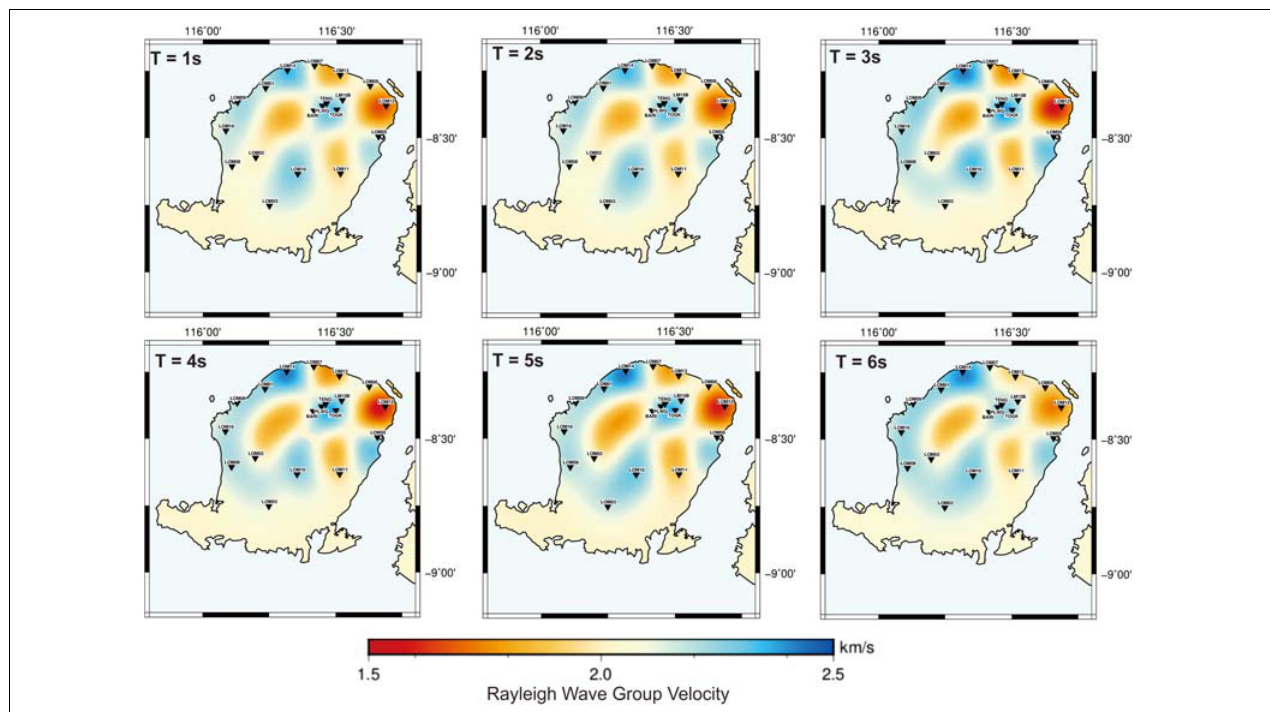
FIGURE 6 | The recovery checkerboard test using a grid size of 15 × 15 km shown in period 1, 2, 3, 4, 5, and 6 s. The black triangles represent the station location.